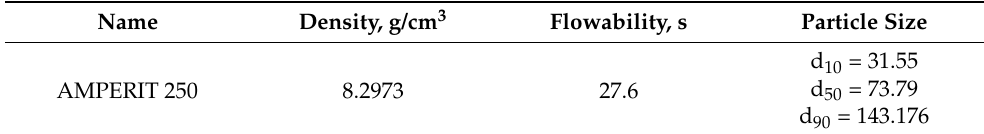
Table 1. Base material properties—commercially available AMPERIT 250 (Ni20Cr)